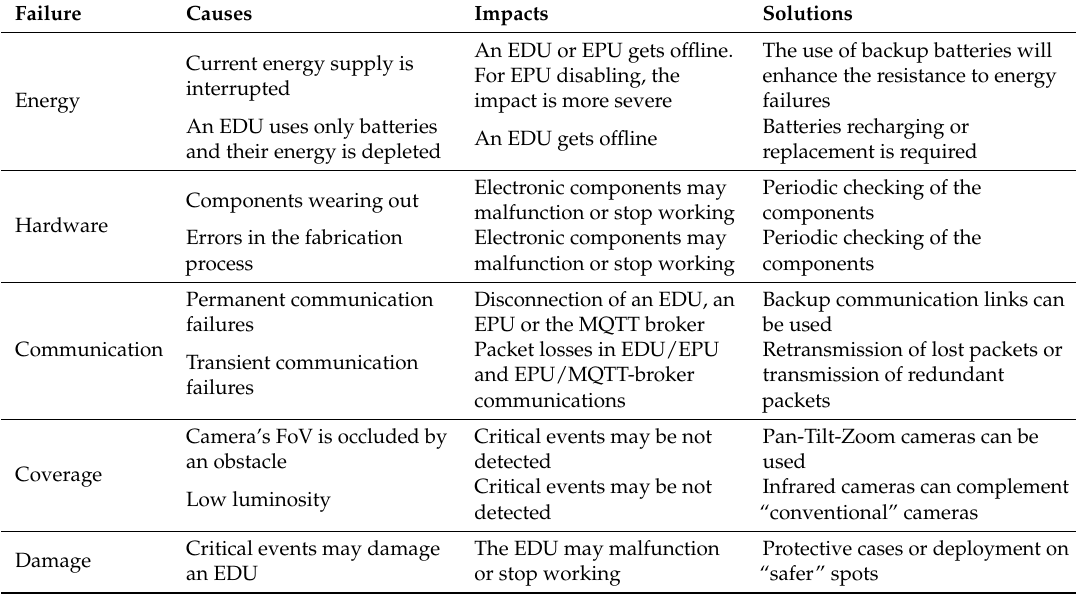
Table 2. Common failures and potential solutions for the proposed